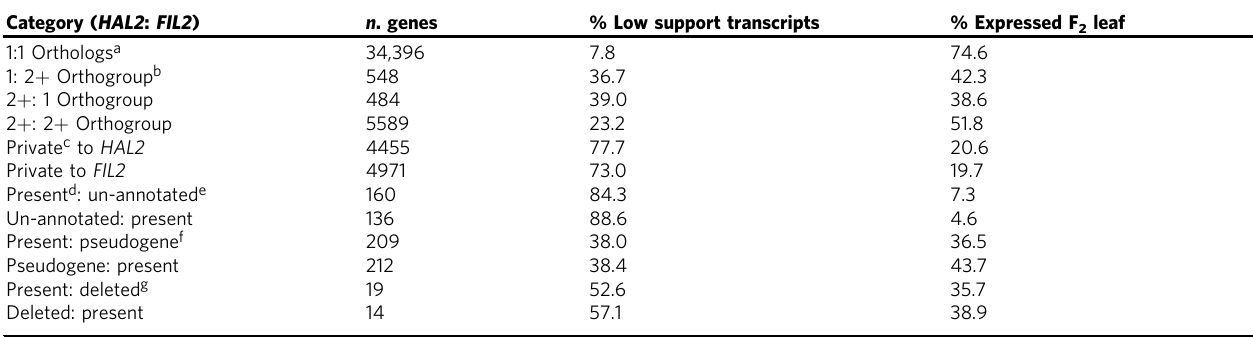
Table 1 Summary of CDS orthology between HAL2 and FIL2 Category ( HAL2 : FIL2 ) n .